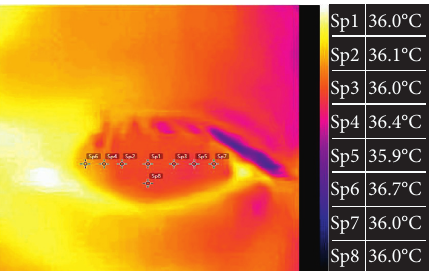
Figure 1: The method in marking the ocular surface and OST acquisition. A typical representation of ocular IRT image as cap- tured by the IRTcamera and assessed by FLIR Tools software. The temperature distributions along 8 anatomical regions of interest are recorded instantaneously. Sp1, central cornea; Sp2, nasal cornea; Sp3, temporal cornea; Sp4, nasal limbus; Sp5, temporal limbus; Sp6, nasal conjunctiva; Sp7, temporal conjunctiva; Sp8, inferior